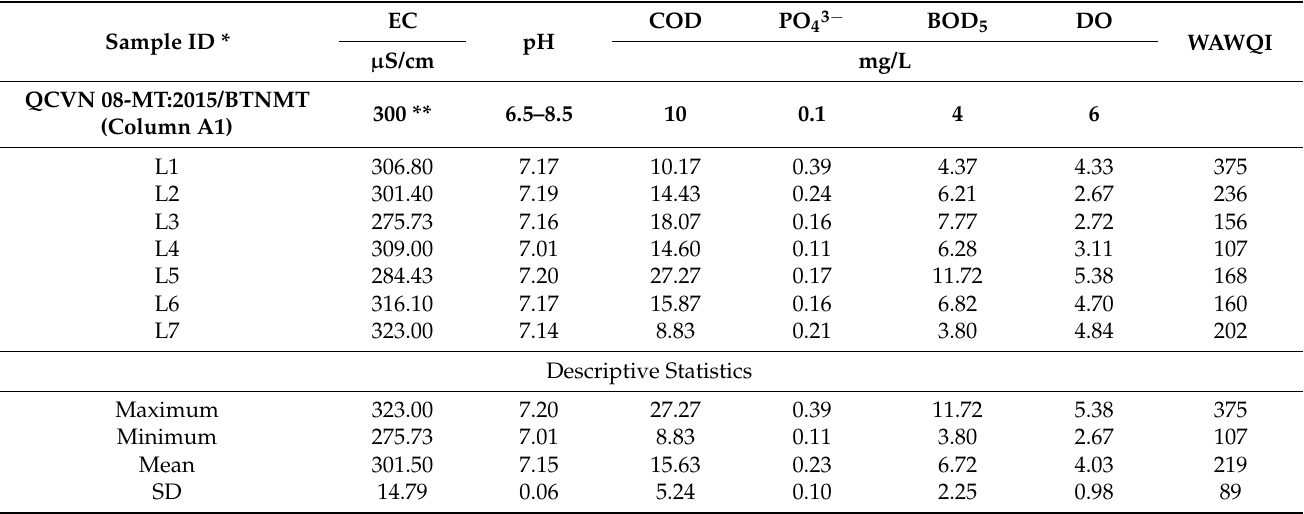
Table 5. Calculation of the WAWQI for the LNHNR in the 2016 Dry